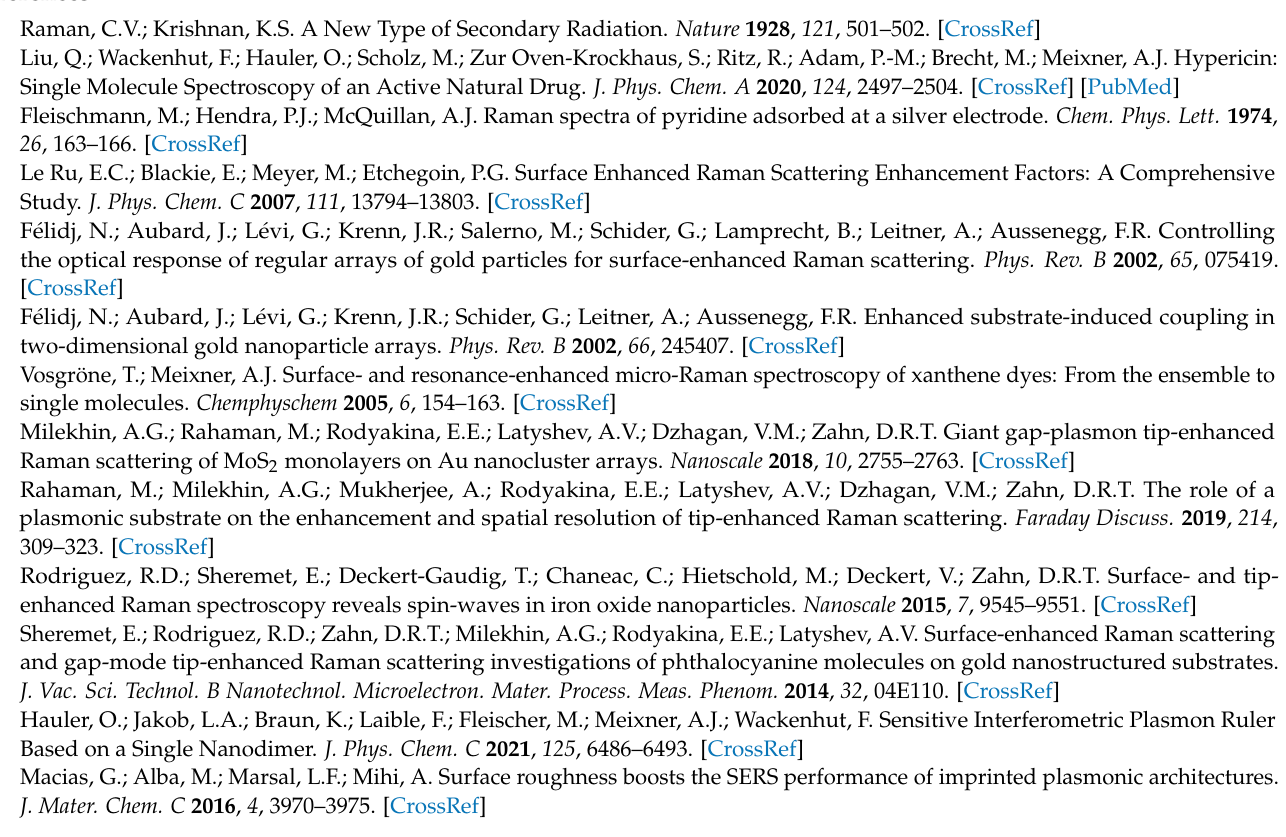
micro and nanoscale reproducibility. Figure S2: (a) Normalized extinction spectra at points P1, P8, and P9 (solid lines—red, blue, black) compared to normalized simulated extinction spectra from Mie theory for spherical gold NPs with radii of 10 nm, 15 nm, and 20 nm (dashed lines—red, blue, black), (b) schematic and equation to determine the symmetry factor of an extinction